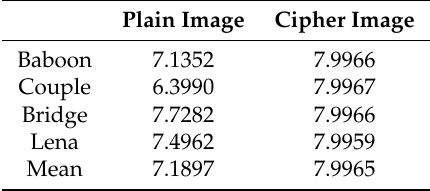
Table 8. Information entropy of plain images and corresponding cipher